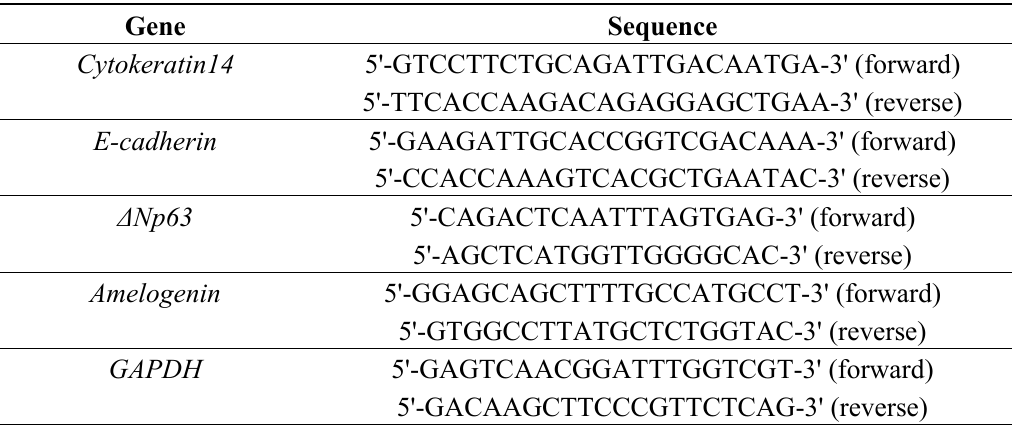
Table1. Sequence of primers used for